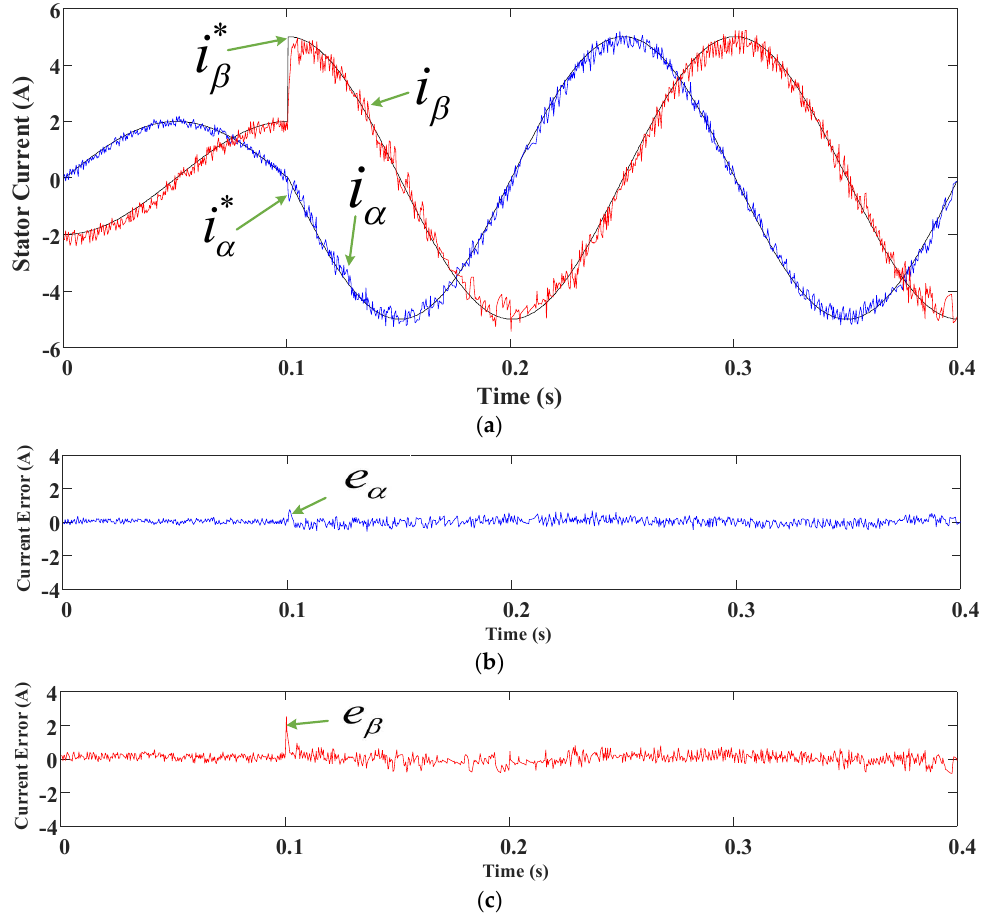
Figure 18. Experimental results of SVV-MFPCC following a sinusoidal current command with amplitude jumping from 2 A to 5 A at 0.1 s under frequency 10 Hz (case 3): ( a ) current responses; ( b ) α -axis current error; ( c ) β -axis current error.